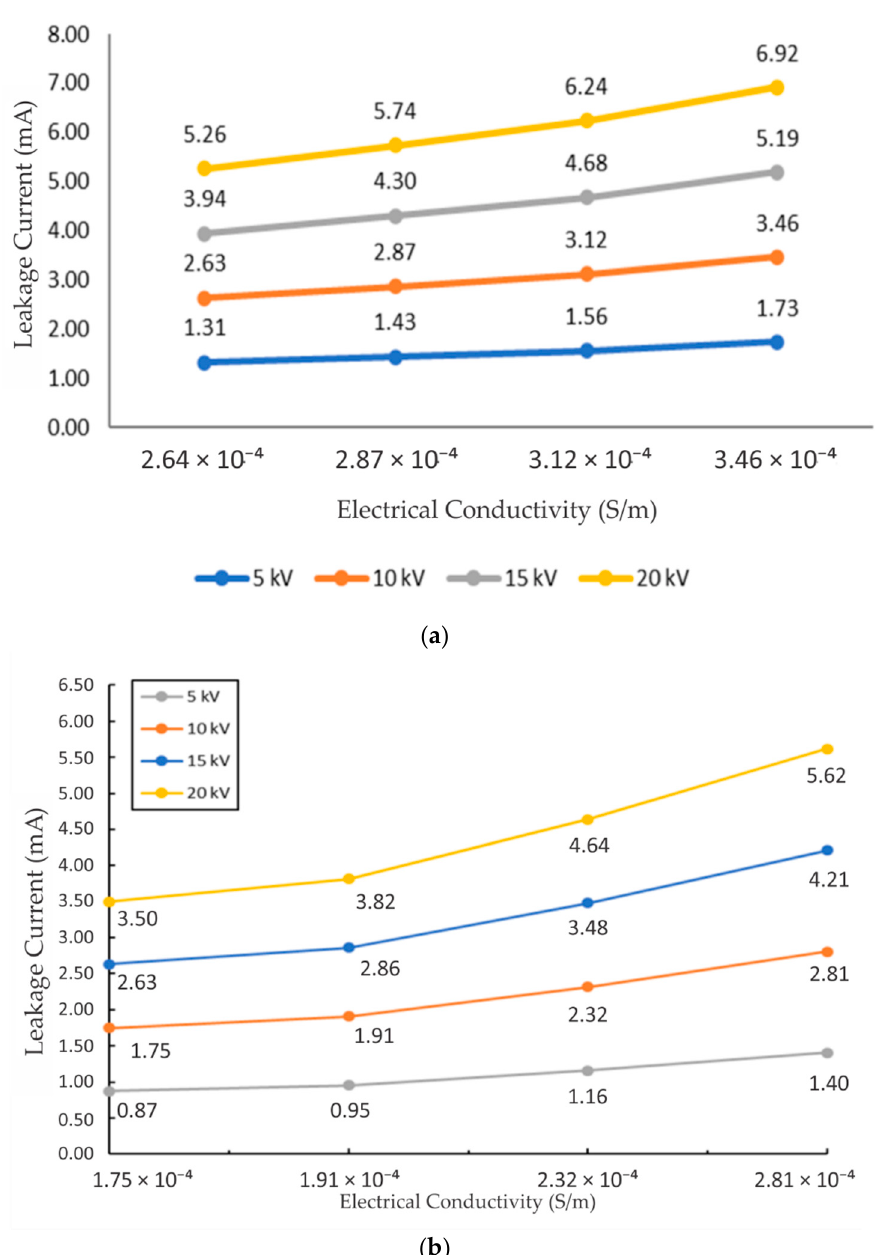
Figure 16. Effect of conductivity on leakage current on the surface of the insulator: ( a ) salt contaminants, and ( b ) fly ash contaminants.